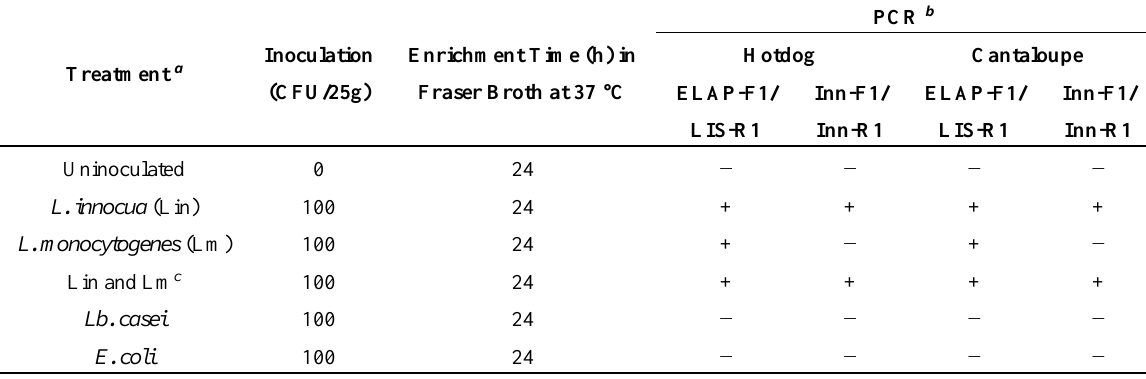
PCR b Hotdog Cantaloupe ELAP-F1/ Inn-F1/ ELAP-F1/ Inn-F1/ LIS-R1 Inn-R1 LIS-R1 Inn-R1